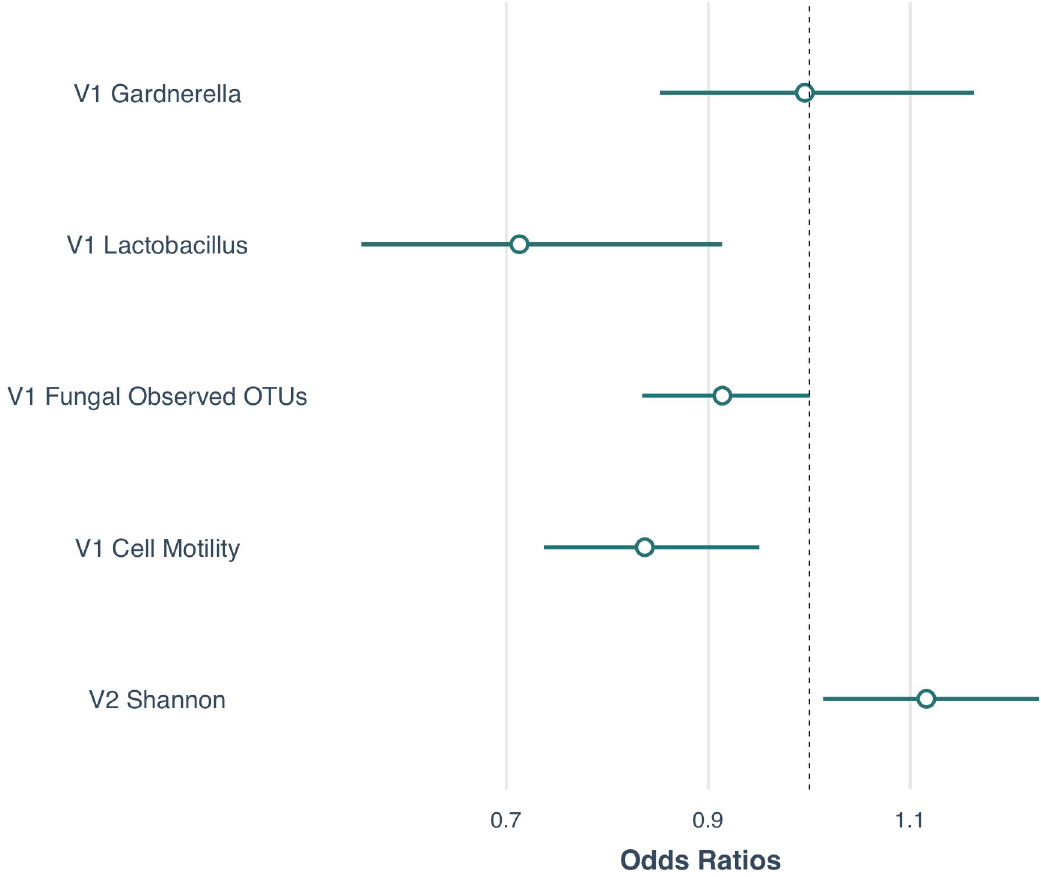
Fig 5. Generalized Linear Model (GLM) results showing the odds ratios of key microbial components in association with progression to CIN2+. The forest plot shows the results of variables evaluated in the univariate analysis that were then entered into a GLM. The model shows ORs (small circle) and 95% confidence interval (line extending on either side of the circle) of the microbial features associated with clearance/progression at either Visit 1 (V1) and/or Visit 2 (V2). The main variables included V1 Gardnerella , V1 Lactobacillus , V1 Fungal Observed OTUs and V1 Cell Motility and V2 Shannon diversity. The model was adjusted for age, bacterial CSTs, smoking and HPV16 infection status. 95% CIs that did not cross the Odds Ratio of 1.0 (dotted vertical line) are considered statistically